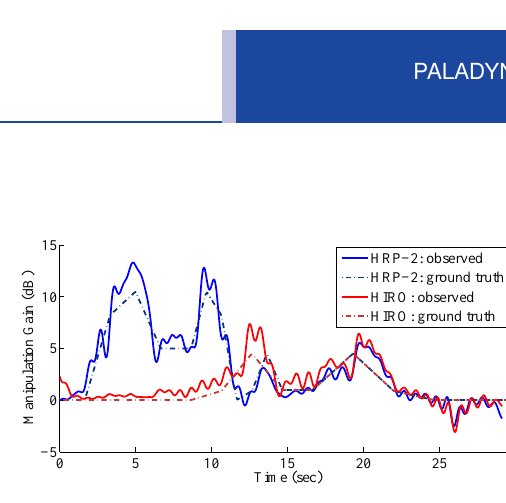
Figure 18. Observed power ratio in 500 Hz band